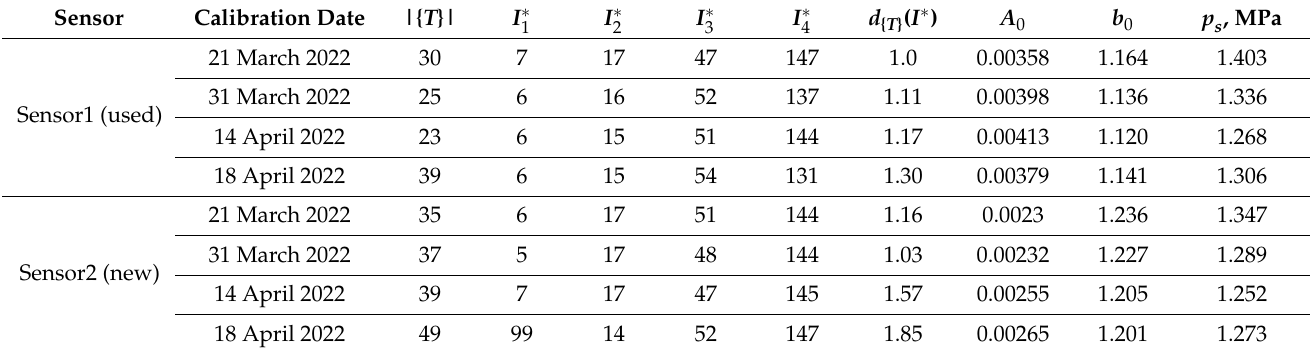
Table 2. Results for the case